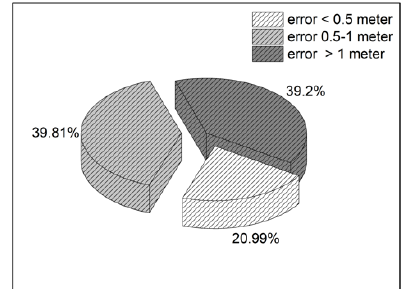
Figure 10. Accuracy of positioning results using MLP.